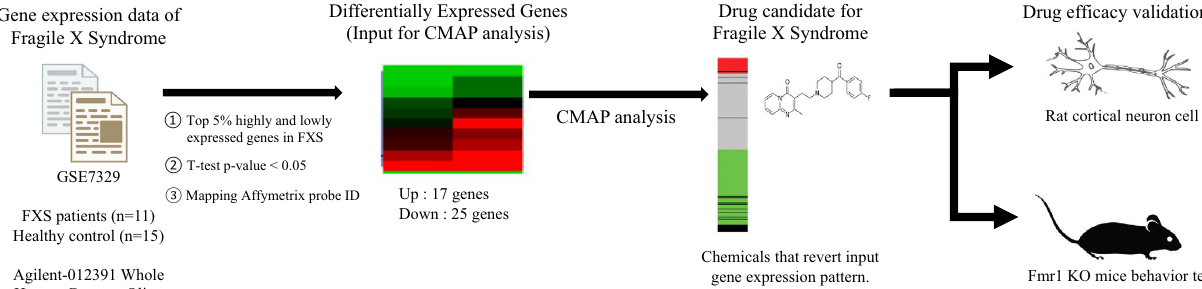
Figure 6. Schematic diagram of the transcriptome, CMap analysis, and therapeutic efficacy validation